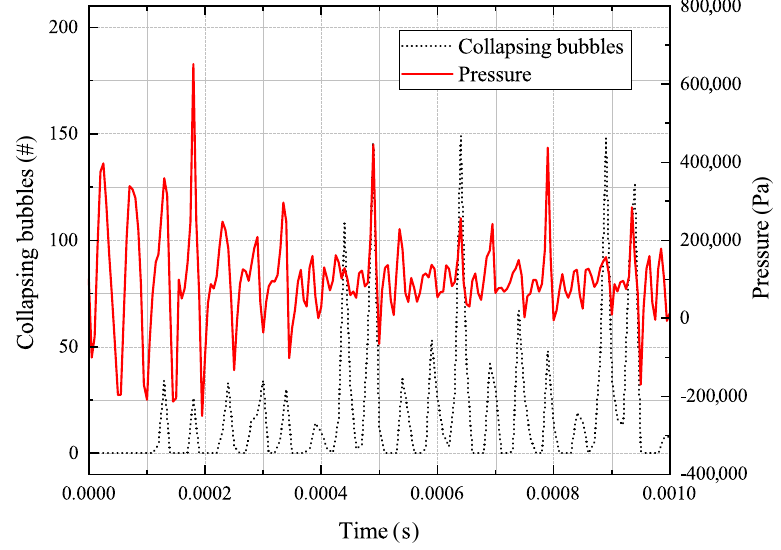
Figure 9. Bubble collapse distribution compared to pressure